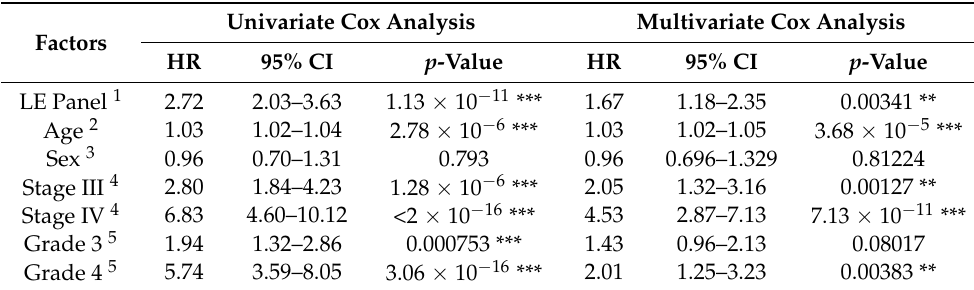
Table 3. Univariate and multivariate Cox analysis of LE gene panel for poor OS (overall survival) of ccRCC (clear cell renal cell carcinoma).